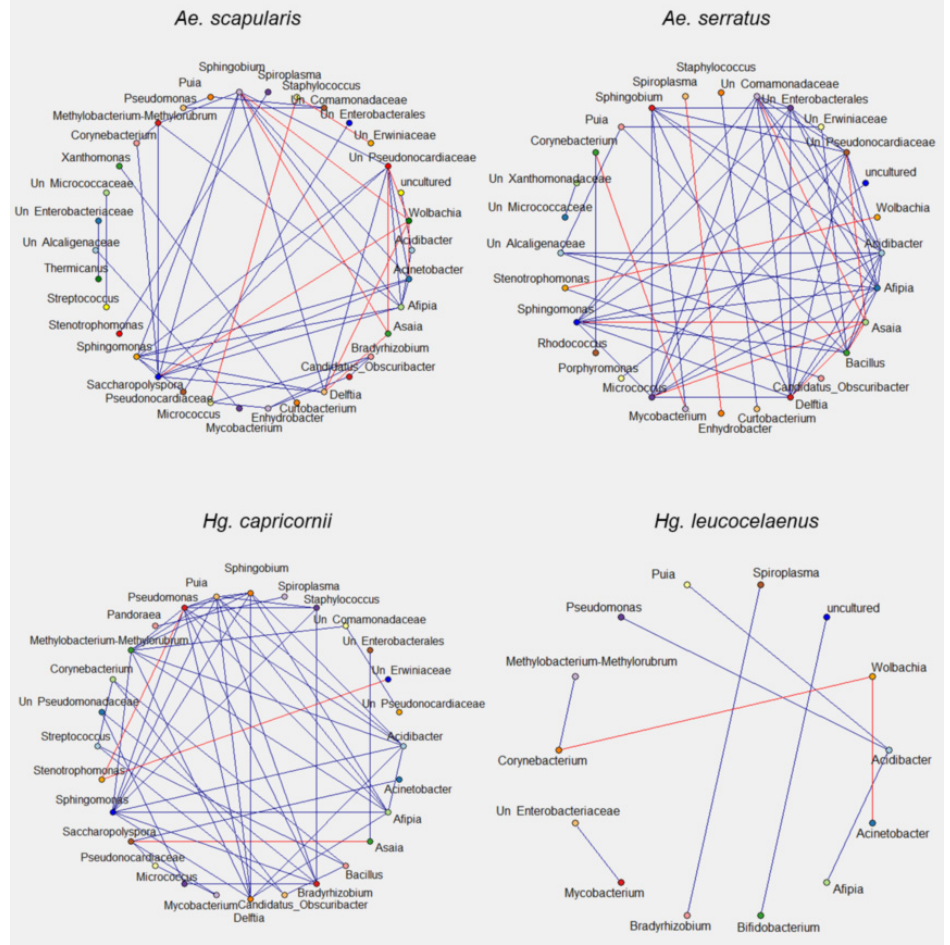
Figure 5. Bacterial interaction network in Ae. scapularis , Ae. serratus , Hg. capricornii and Hg. leucocelaenus . Each colored circle represents a bacterial taxon. Blue line corresponds to positive correlation between taxa. Red line represents negative correlation between taxa. Correlations were obtained by Spearman and only considered correlations with r > 0.75 and p > 0.05.